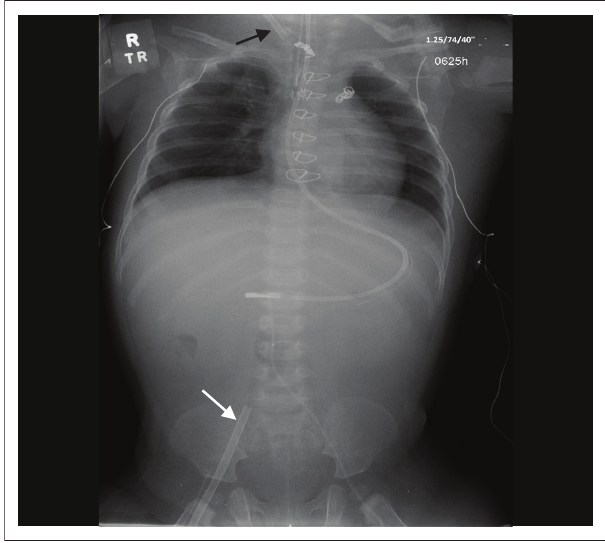
FIGURE 4: Chest radiograph showing a veno-arterial extracorporeal membrane oxygenation placed in a 1-year-old male child with respiratory failure, with the arterial cannula in the right internal carotid artery (black arrow) and the venous cannula in the right femoral vein (white TABLE 1: Various extracorporeal membrane oxygenation configurations and their indications. Cannula tip position